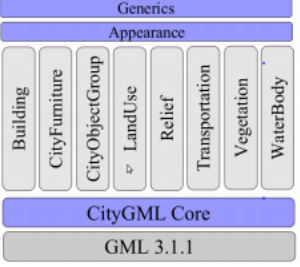
Figure 5 Modularization of CityGML 1.0.0 (Kolbe, 2009) CityGML represents four different aspects of virtual 3D city